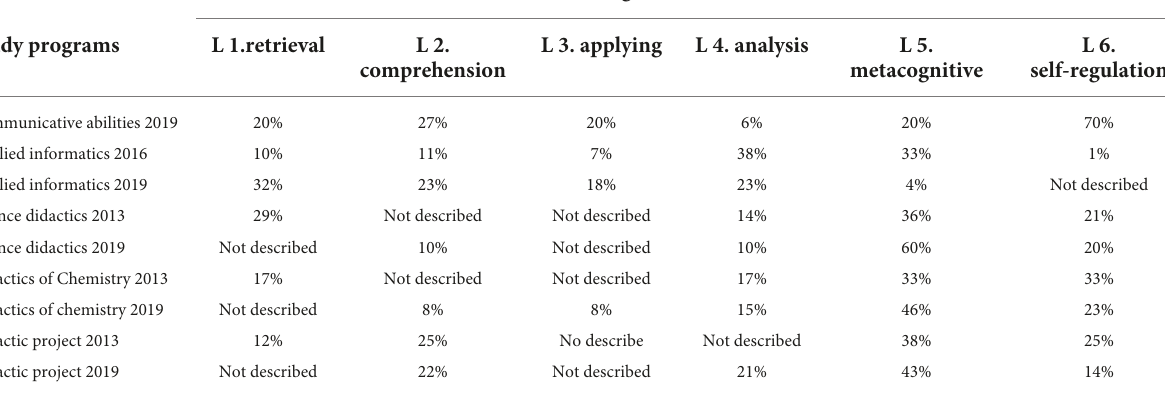
TABLE 7 A priori content analysis of the study programs through the cognitive domains developed during the initial training of chemistry